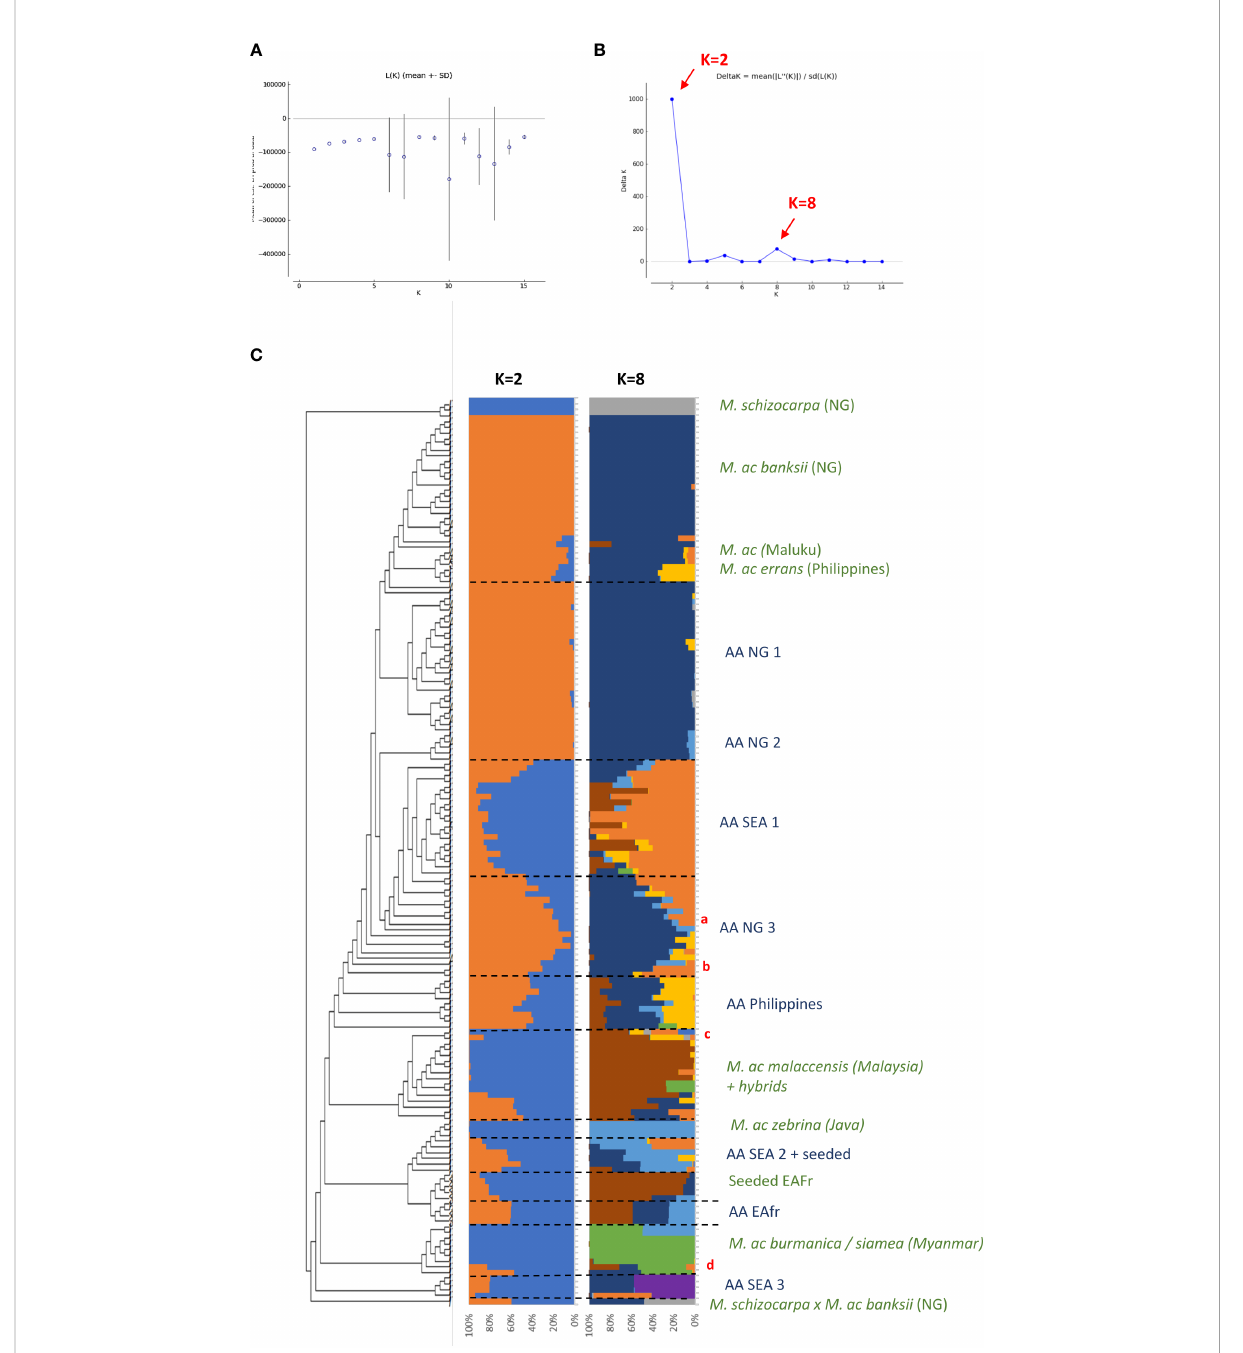
FIGURE 1 (A, B) present the results of the Bayesian clustering of the diploid bananas pruned sample (158 accessions) using STRUCTURE v2.3 (Pritchard et al., 2000) evaluated using STRUCTURE HARVESTER (Earl and vonHoldt, 2012) and based on the lnP(D)/K and DeltaK, respectively. (C) Presents the global genetic structure of the pruned sample of 158 genotypes. The cladogram was obtained from the NJ tree constructed with DARwin 6 (Perrier and Jacquemoud-Collet, 2006) on the Simple-Matching distance matrix calculated on 66,481 biallelic SNPs and using FigTree v1.4.3 (Rambaut, 2006-2016) and the R package ape (Paradis and Schliep, 2019). Bar plots represent STRUCTURE outputs for K=2 and K=8 as inferred from 1,278 SNPs distributed evenly across the genome, each bar corresponds to a genotype and colours correspond to the detected ancestral genepools. EAfr: East Africa; SEA: South-East Asia; NG: New-Guinea Island; a: ITC0299 ‘ Guyod ’ from the Philippines, b: ITC0447 ‘ Pu-Te Wey ’ from Malaysia, c: ITC1701 M. acuminata ssp. sumatrana from Sumatra and ITC0393 M. acuminata ssp. truncata from Malaysia, d : ITC1761 ‘ Matti ’ from India and ITC0610 ‘ Tuu Gia ’ from